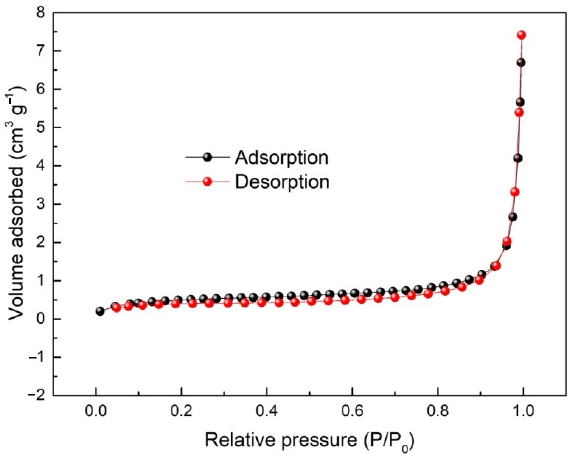
Figure 6. Nitrogen adsorption–desorption isotherms of MoO 3 /MoS 2 @G ‐ 1100.